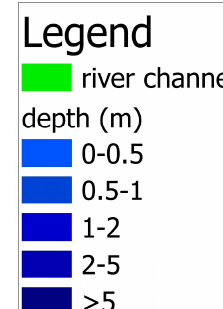
Figure 7. Comparison between the 6 hydrodynamics simulations characterized by a different set of Manning coefficient values and the SAR- and DEM-derived water-depth map for 3 December 2013.